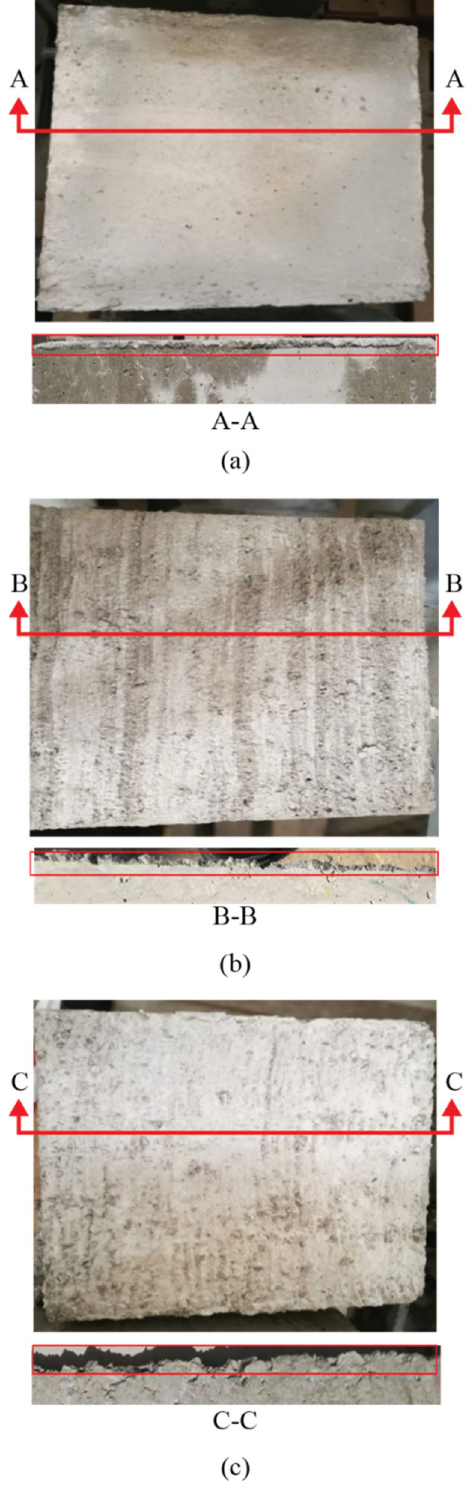
Figure 3. Concrete specimens with ( a ) smooth (as-cast), ( b ) medium rough (wire-brushed), and ( c ) rough (raked) surface